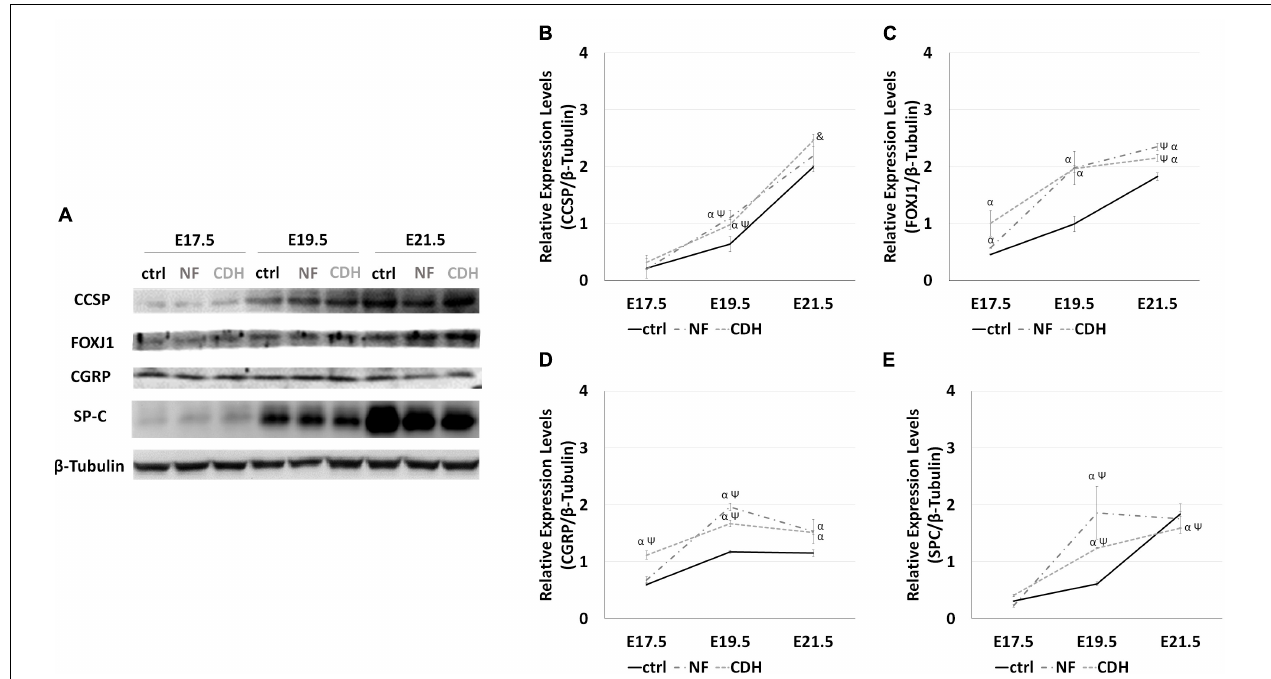
FIGURE 1 | Altered relative expression levels for clara cell secretory protein (CCSP), forkhead box J1 (FOXJ1), calcitonin gene-related peptide (CGRP), and surfactant protein-C (SP-C) in hypoplastic rat lungs. Western blot analysis for CCSP, FOXJ1, CGRP, and SP-C protein levels in normal (ctrl) and CDH lungs at embryonic day (E)17.5-to-E21.5. (A) Representative immunoblots are shown. Each lane represents a pooled tissue sample, and relative expression was determined against β -tubulin. Semi-quantitative analysis of three independent experiments is plotted ( n = 9 per timepoint and experimental groups, respectively). Protein expression levels of (B) CCSP, (C) FOXJ1, (D) CGRP, and (E) SP-C are shown at the distinct developmental stages of normal, nitrofen (NF), and congenital diaphragmatic hernia (CDH) fetal lungs. Results are presented as mean ± SD. Symbols indicate the main effects and non-redundant interactions of the